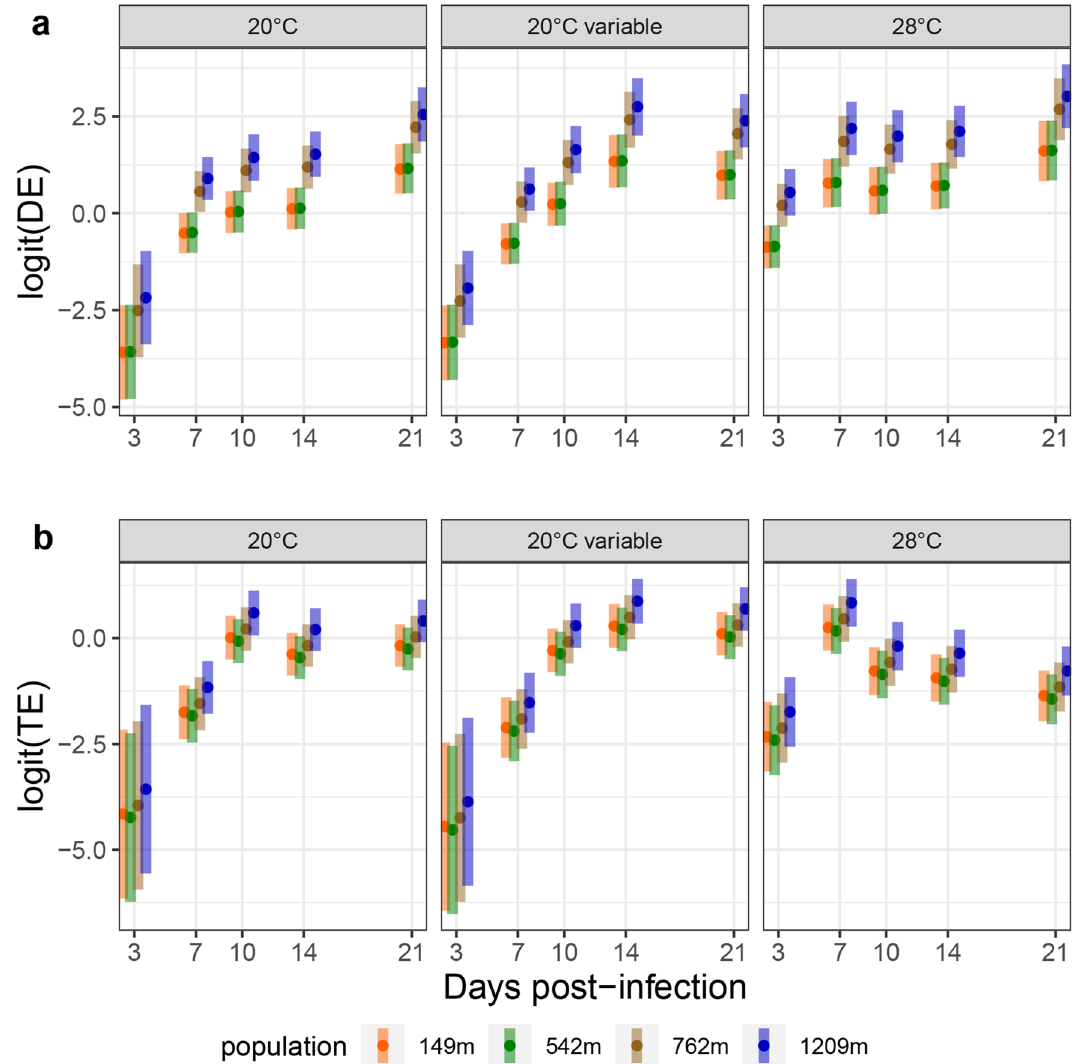
Figure 3. Predicted value of Dissemination Efficiency (DE, panel a ) and Transmission Efficiency (TE, panel b ) according to days-post infection, modeled using logistic regression. In both panels, graphs show the expected marginal means (dots) with corresponding 95% confidence intervals (bars) on the logit scale, highlighting the interacting effect of temperature on days